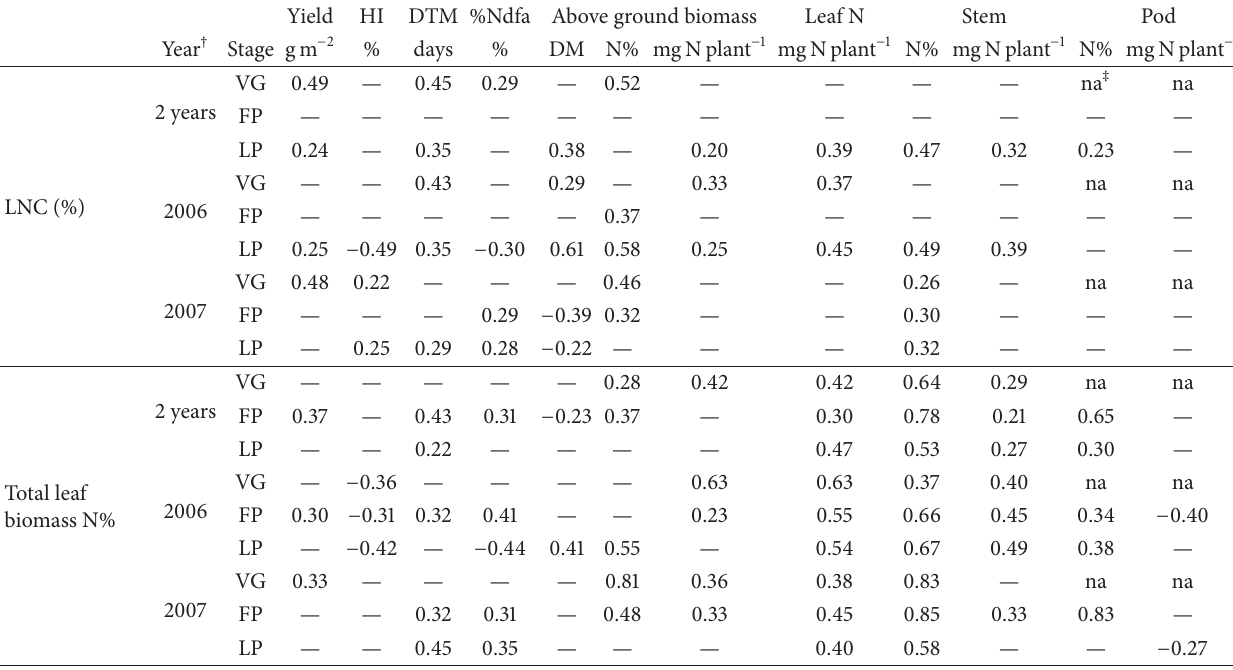
Table 2: Correlation coefficients of LNC and N concentration of the entire leaf biomass with lentil performance in the N fertility trial in three stages of vegetative (VG), first pod (FP), and late-pod (LP). Yield HI DTM %Ndfa Above ground